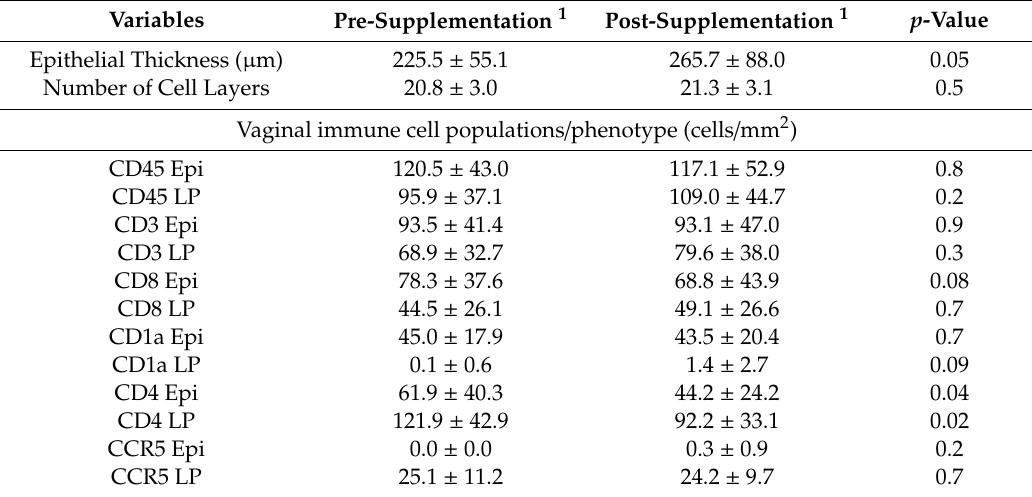
Table 2. Changes in vaginal immune cell expression levels due to vitamin D